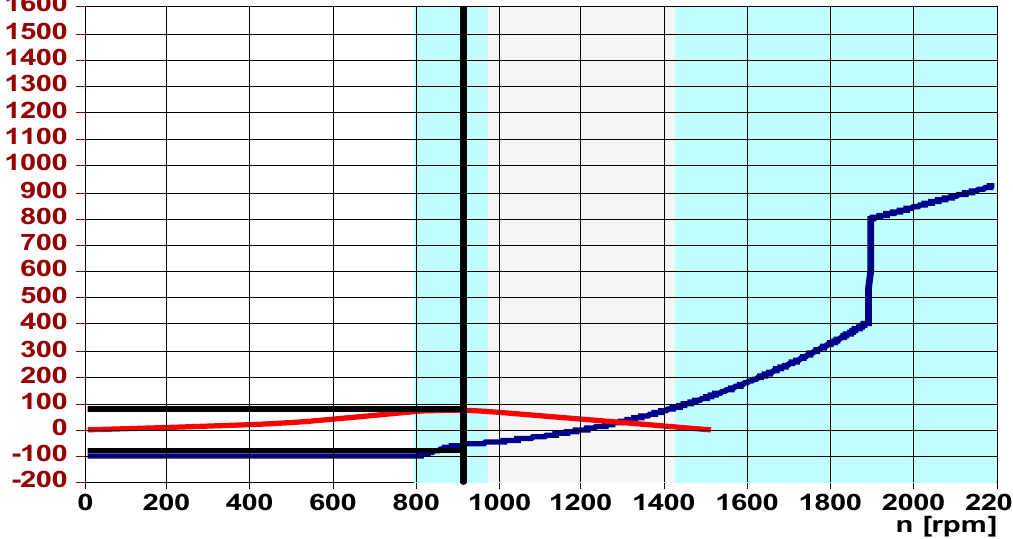
Figure 19. A wind turbine based on DFIG with a speed of 4.5 m/s.